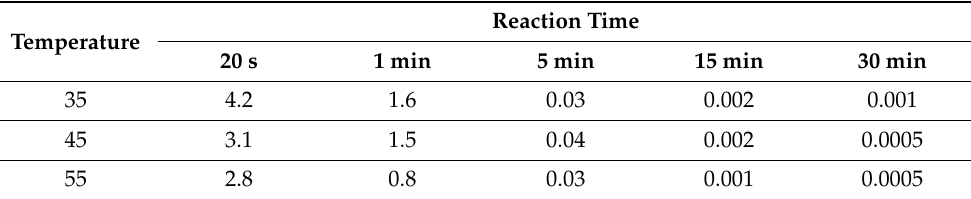
Table 6. Cd 2+ concentration (g/L) changes at different